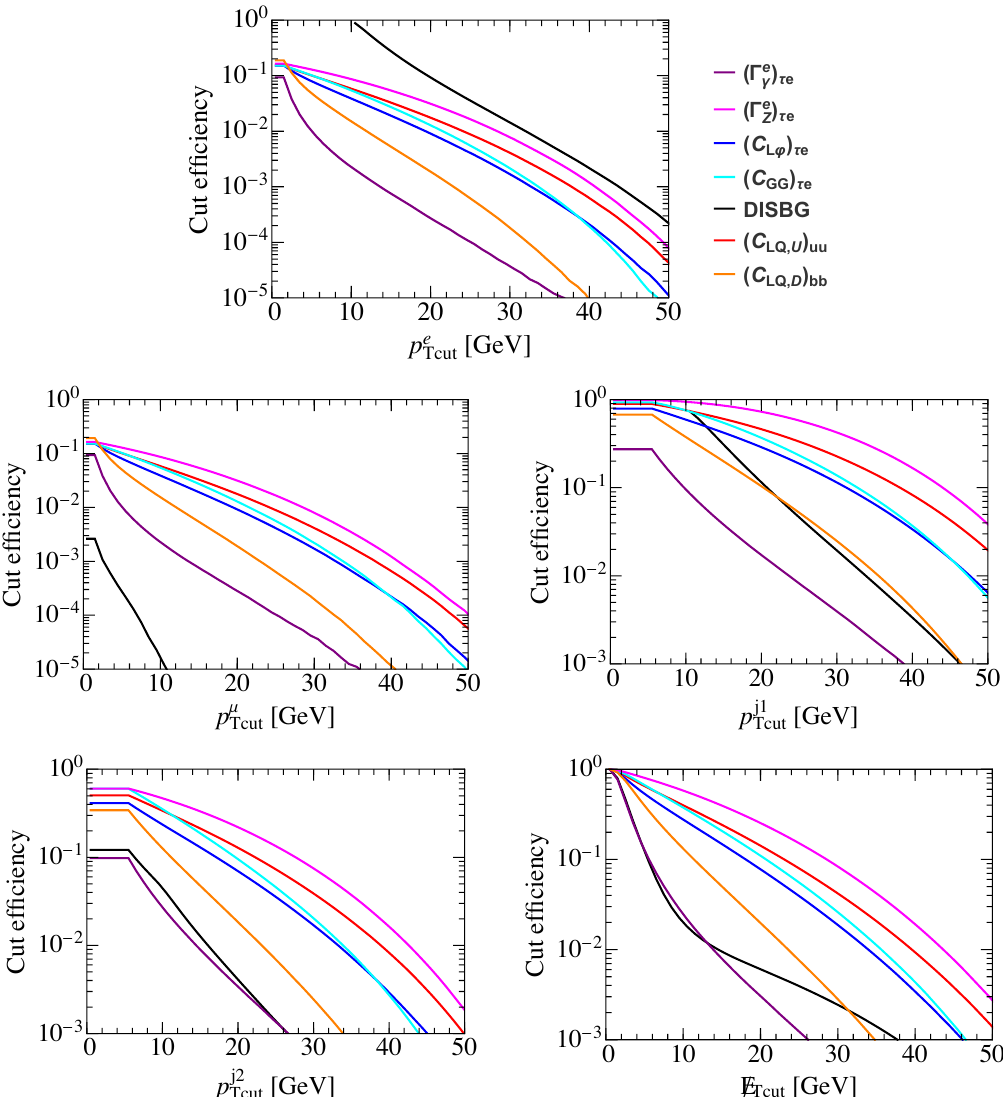
Figure 7 . Cut efficiency for the SM background (DISBG) and the signal induced by SMEFT operators with left-handed τ leptons, as a function of the cut on the electron, muon, leading and subleading jet p or on the missing energy. We only implement one cut at a T